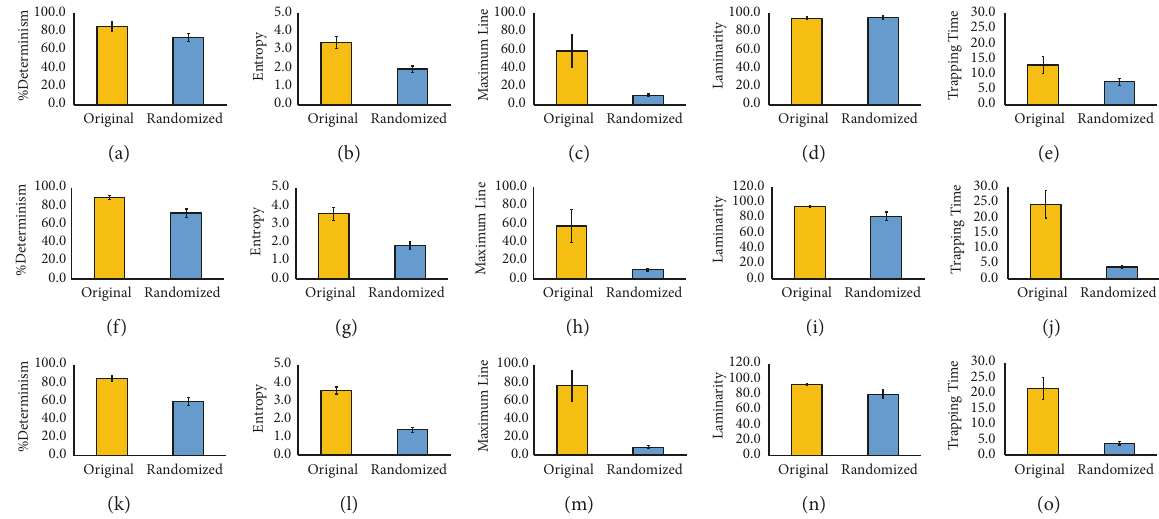
Figure 5: Mean and standard errors of determinism (Panels (a), (f), and (l)), entropy (Panels (b), (g), and (m)), maximum line (Panels (c), (h), and (n)), laminarity (Panels (d), (i), and (o)), and trapping time (Panels (e), (j), and (p)) when segmenting by dyads (child-caregiver, child-stranger, and